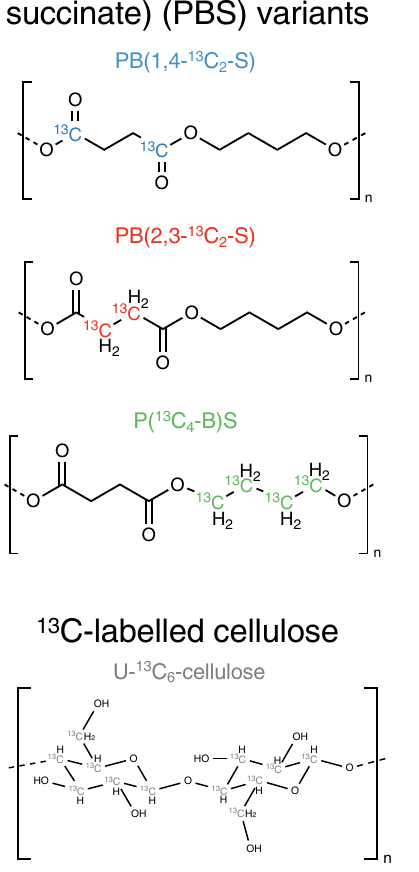
Fig. 6 | Chemical structures of the 13 C-labelled poly(butylene succinate), cor- responding monomers, and cellulose used in experiments. Substrates include the three variants of 13 C-labelled poly(butylene succinate) (PBS) (i.e., PB(1,4- 13 C 2 -S);